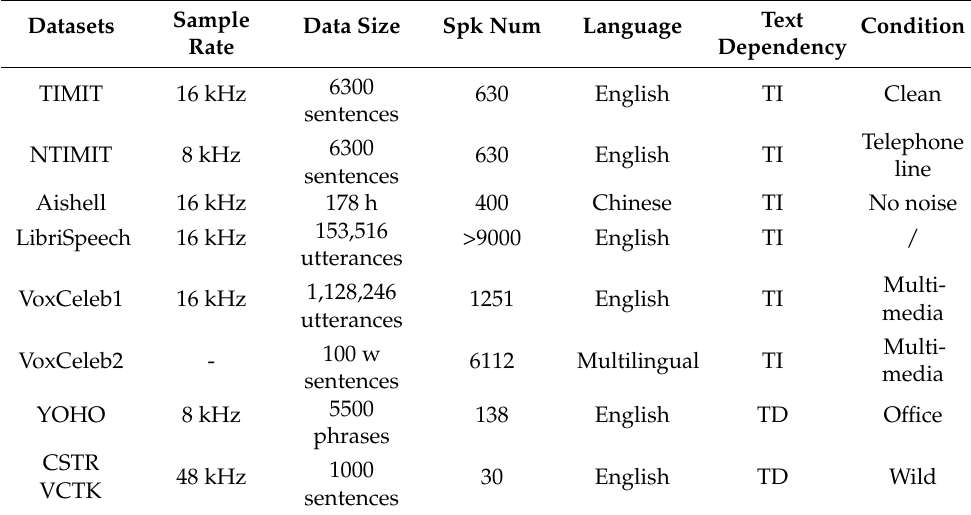
Table 2. Generic datasets for speaker